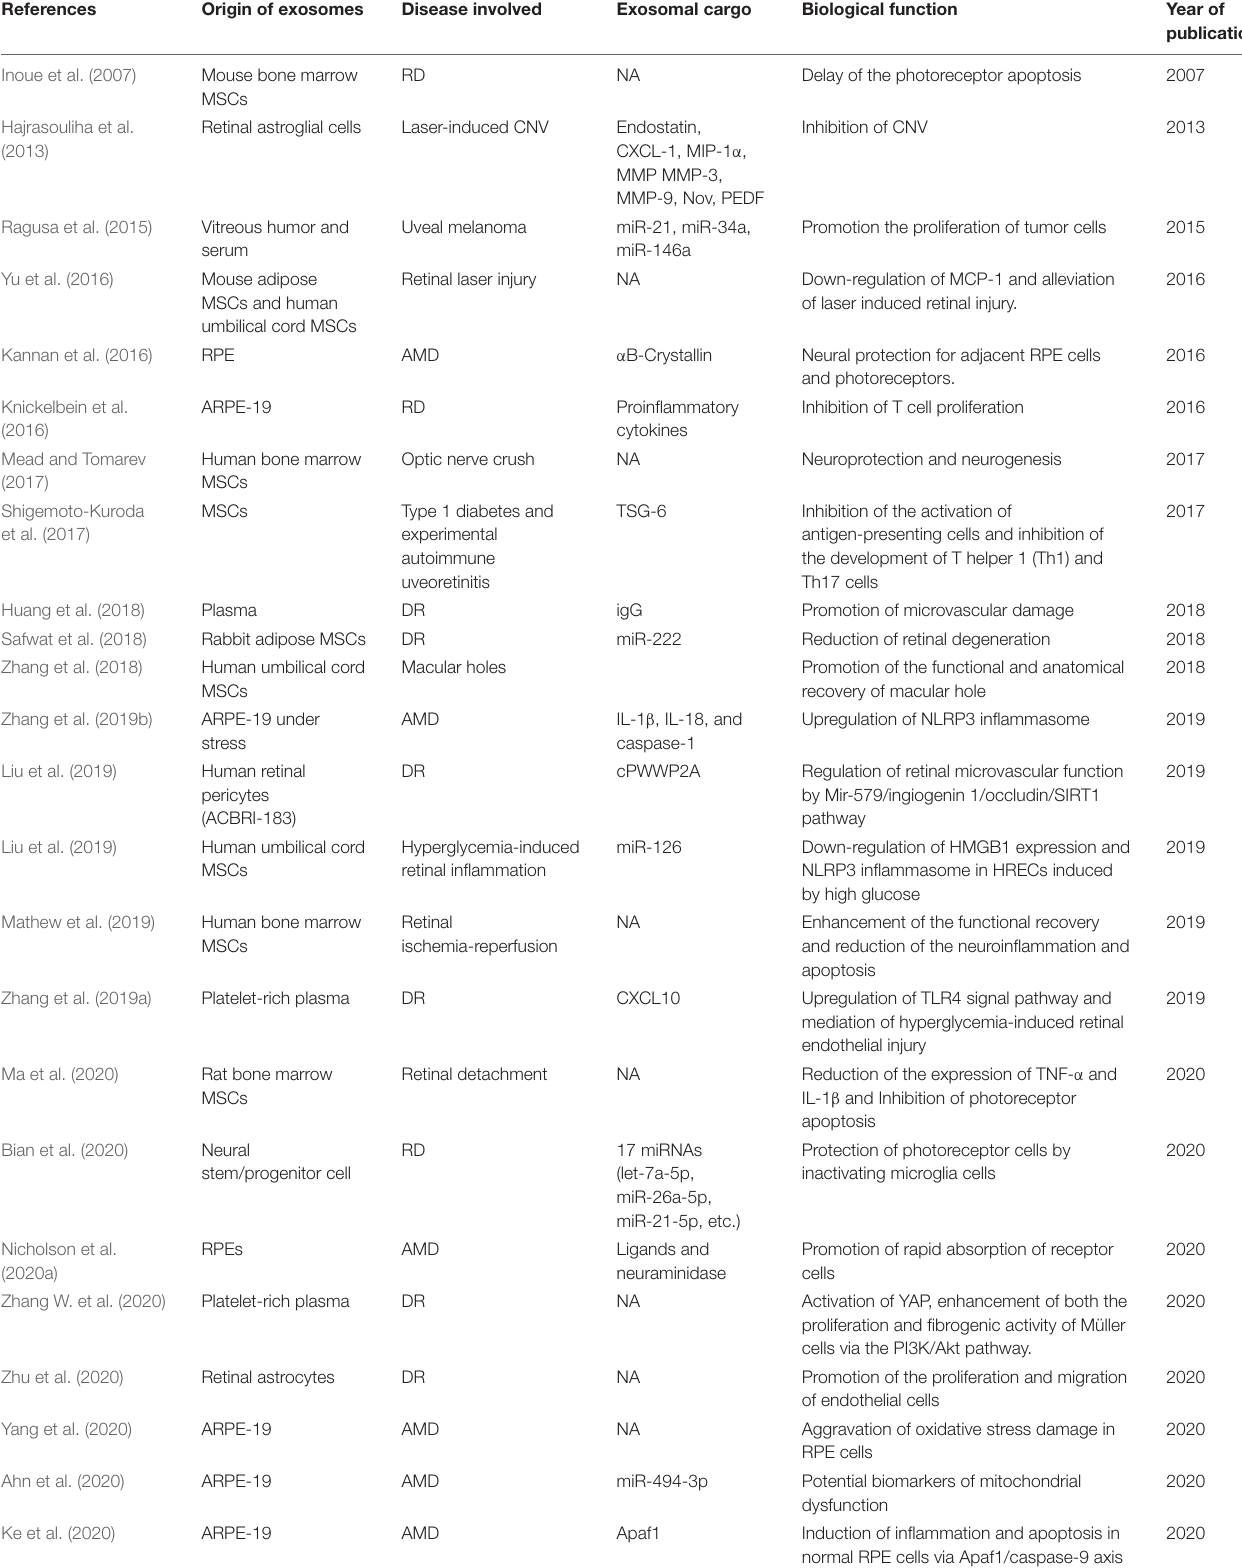
TABLE 2 | A selective overview of studies reporting exosomes in retina